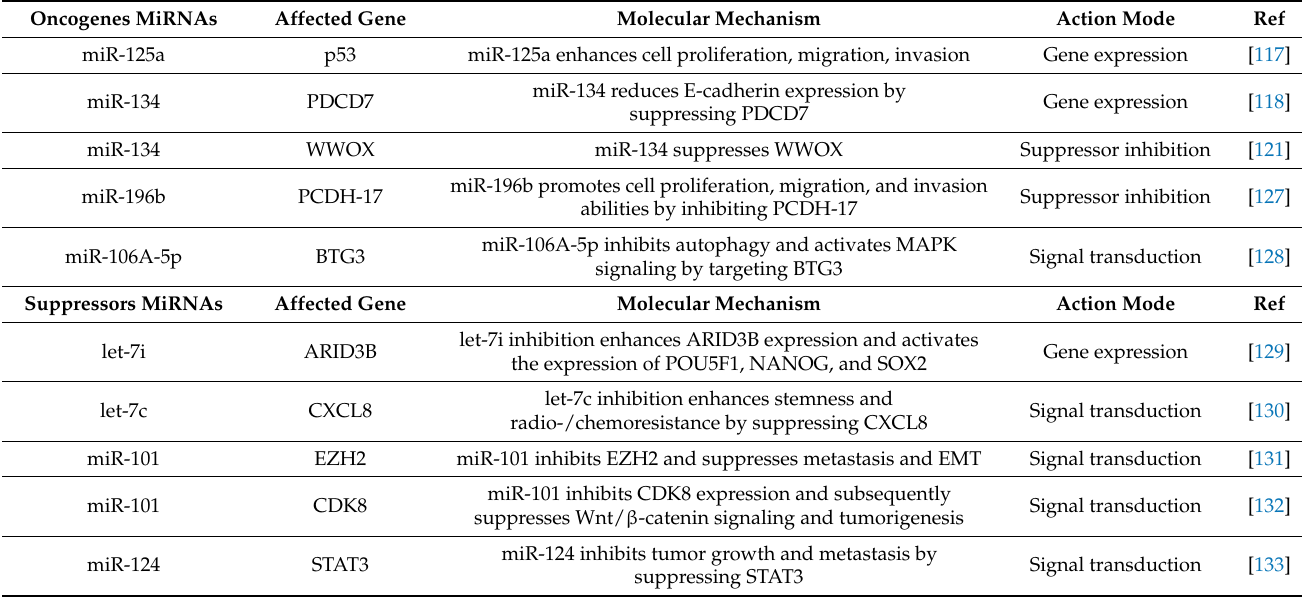
Table 1. Selected genes and their action mechanism in